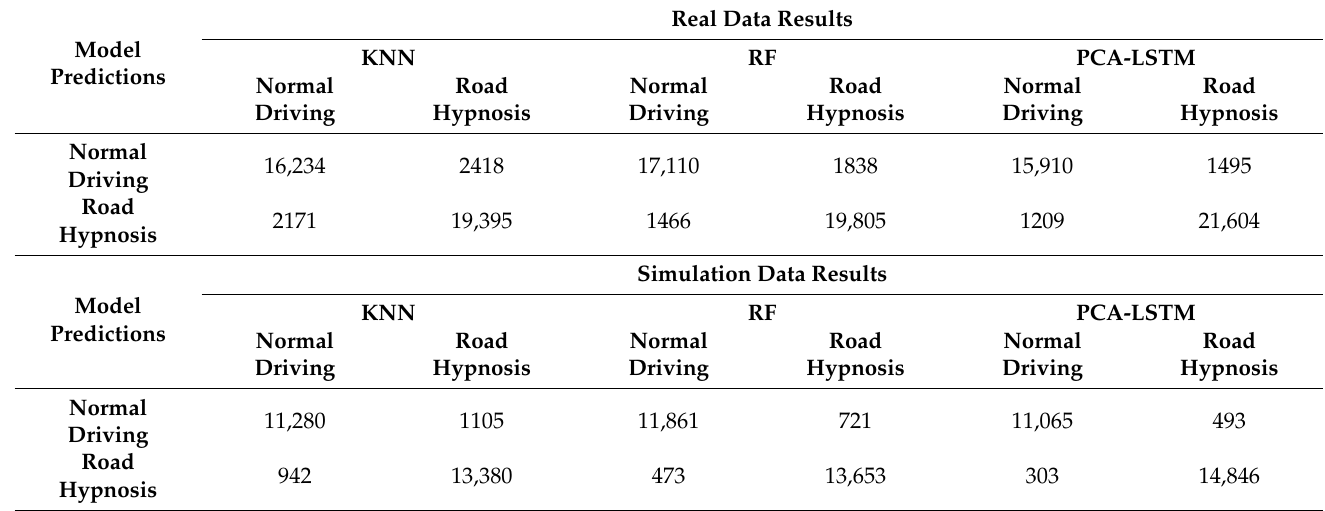
Table 9. Validation results of the